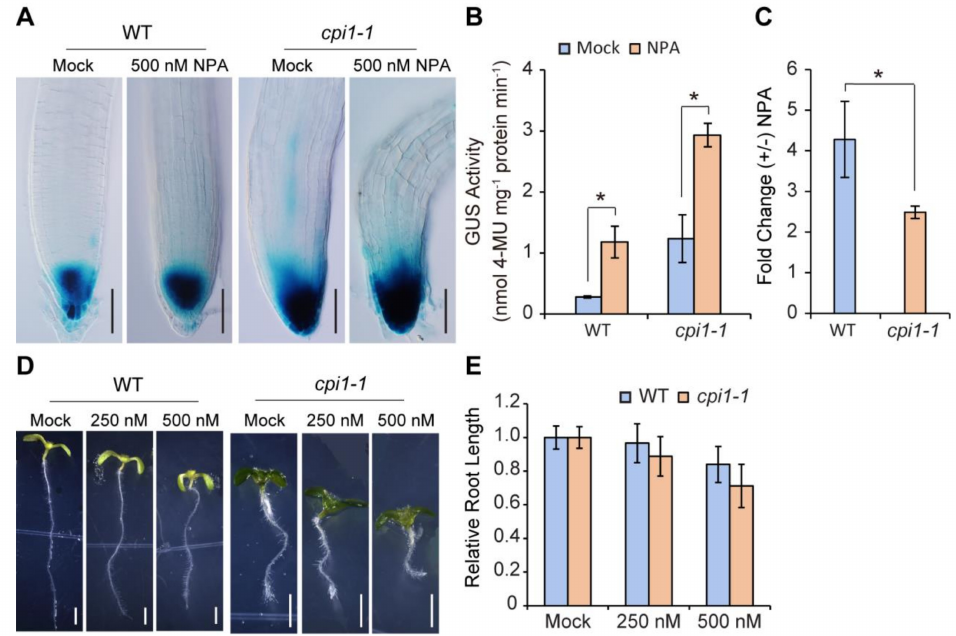
Figure 2. The auxin transport inhibitor 1- N -naphthylphthalamic acid (NPA) increases the DR5:GUS signal in WT and cpi1-1 root tips. ( A ) NPA increases the DR5:GUS signal in 5-day-old WT and cpi1-1 seedling root tips. Shown are representative images of n = 3 independent experiments, employing 7 to 21 seedlings per experiment; ( B ) Quantitative GUS activity